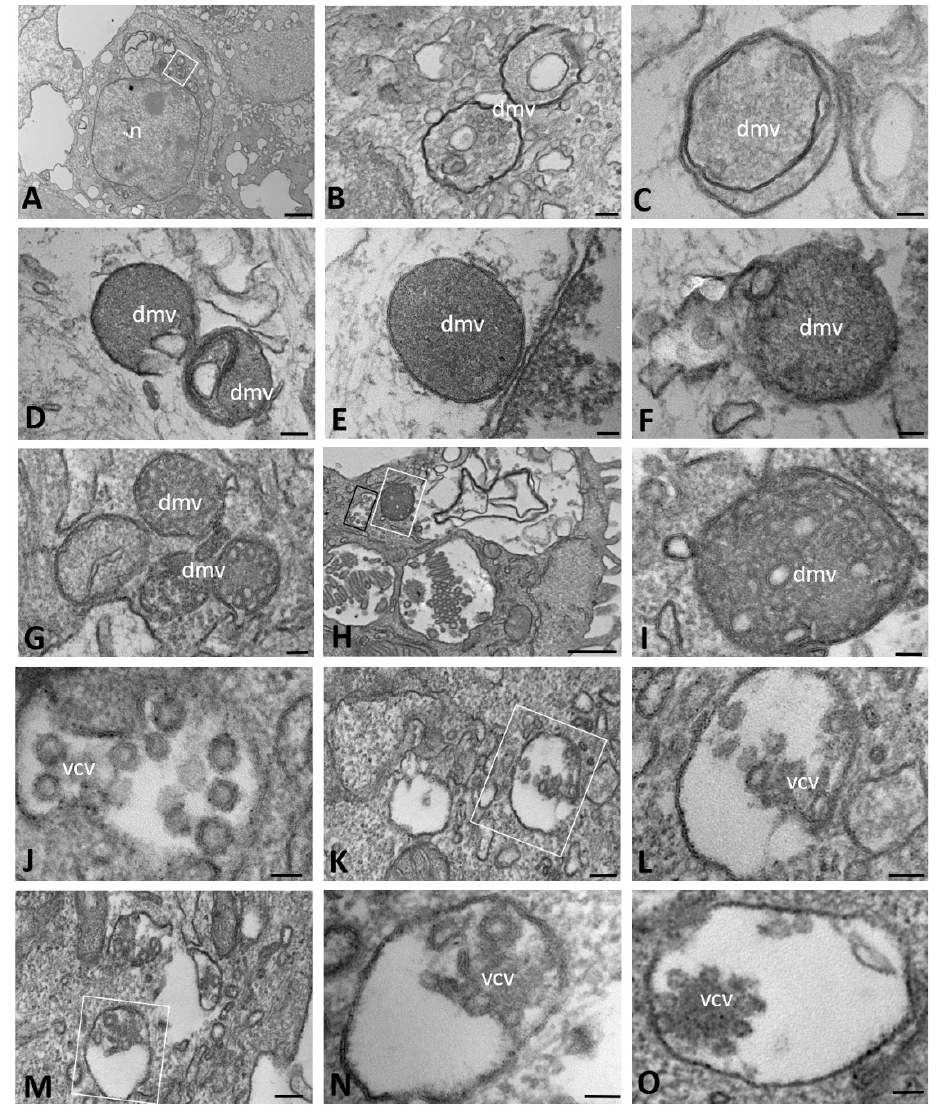
Figure 5. Transmission electron microscopy showing viral replicative structure of SARS-CoV-2 infected CFBE41o- ∆ F cells at late time points of infection (from 24 to 72 h post infection). Double- membrane vesicles with granular ( A – F ) and vesicular ( G – I ) content are visible. Virions are detected in single-membrane-bound vesicles ( J – O ) lacking well-defined organization. The boxed areas in ( A , K , M ) are enlarged in ( B , L , N ), respectively. The black boxed area in ( H ) is enlarged in ( J ) and the white boxed area is enlarged in ( I ). (dmv): double-membrane vesicle; (n): nucleus; (vcv): virion- containing vesicle. Bars: ( A ) 1 µ m; ( H ) 500 nm; ( B , D , K , M ) 100 nm; ( C , E – G , I , J , L , N , O ) 50